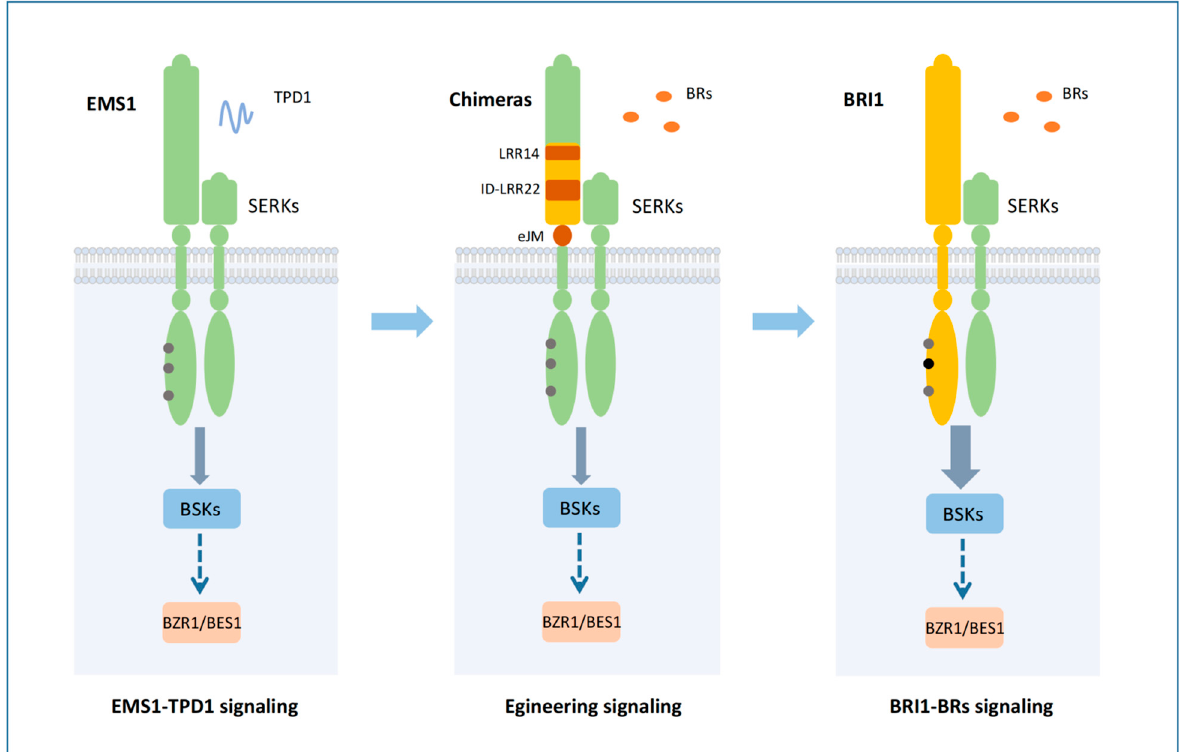
Figure 7. A proposed model for the molecular mechanisms of EMS1 and BRI1 signaling and the origin and divergence of BR receptor. The left side of the model diagram shows the molecular mechanism of EMS1-TPD1 signaling. The ligand TPD1 binds to EMS1 and activates the complex composed of EMS1-SERKs. The intracellular domain of EMS1 interacts with the direct substrate BSKs to initiate the signal transduction pathway. The three tyrosine phosphorylation sites Y990, Y1085, and Y1090 shown in the kinase domain of EMS1 are involved in the regulation of kinase activity. The middle diagram represents the chimeric receptor signaling mechanism. When the LRR14-eJM region in EMS1 was replaced with that of BRI1, the EMS1 chimeric receptor gained the ability as a BR receptor The LRR14-eJM region includes at least three important motifs including LRR14, ID-LRR12, and eJM domain. The right side of the model diagram shows the molecular mechanism of BRI1-BRs signaling. The corresponding phosphorylation sites Y956, Y1052, and Y1057 in the kinase domain of BRI1 are involved in the regulation of kinase activity, but only Y1052 is an essential phosphorylation site for BRI1 function. Due to the stronger kinase activity of BRI1 than EMS1, BRI1 has a stronger signal output ability than EMS1. Our experiments revealed that the functional divergence of BRI1 and EMS1 exists in the receptor’s extracellular domain. Therefore, three important motifs in the LRR14-eJM region may be the key molecular components in the origin of the BR receptor.